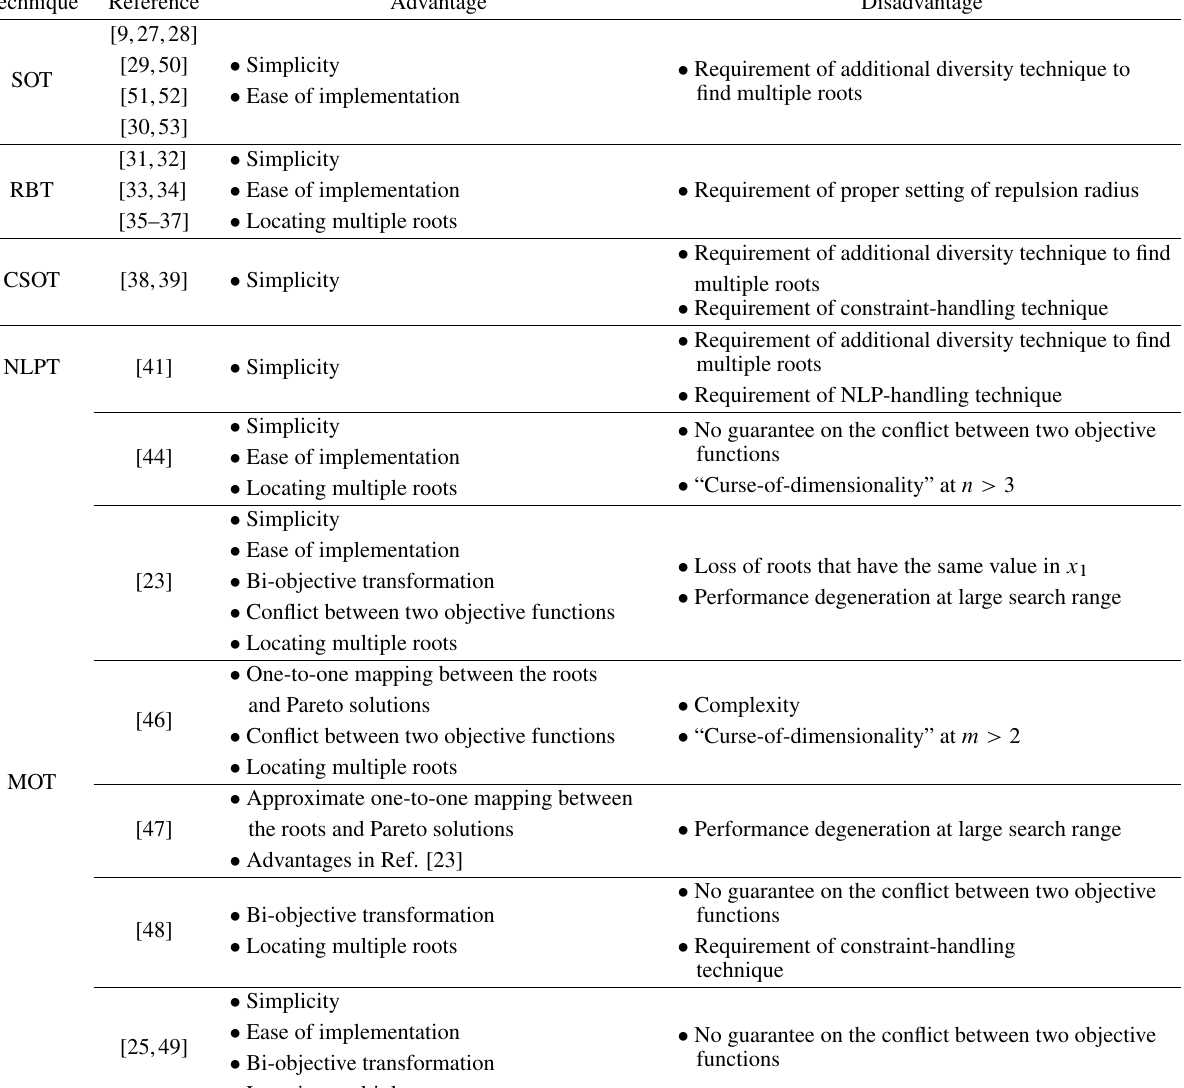
Table 1 Summary of the advantages and disadvantages of different transformation